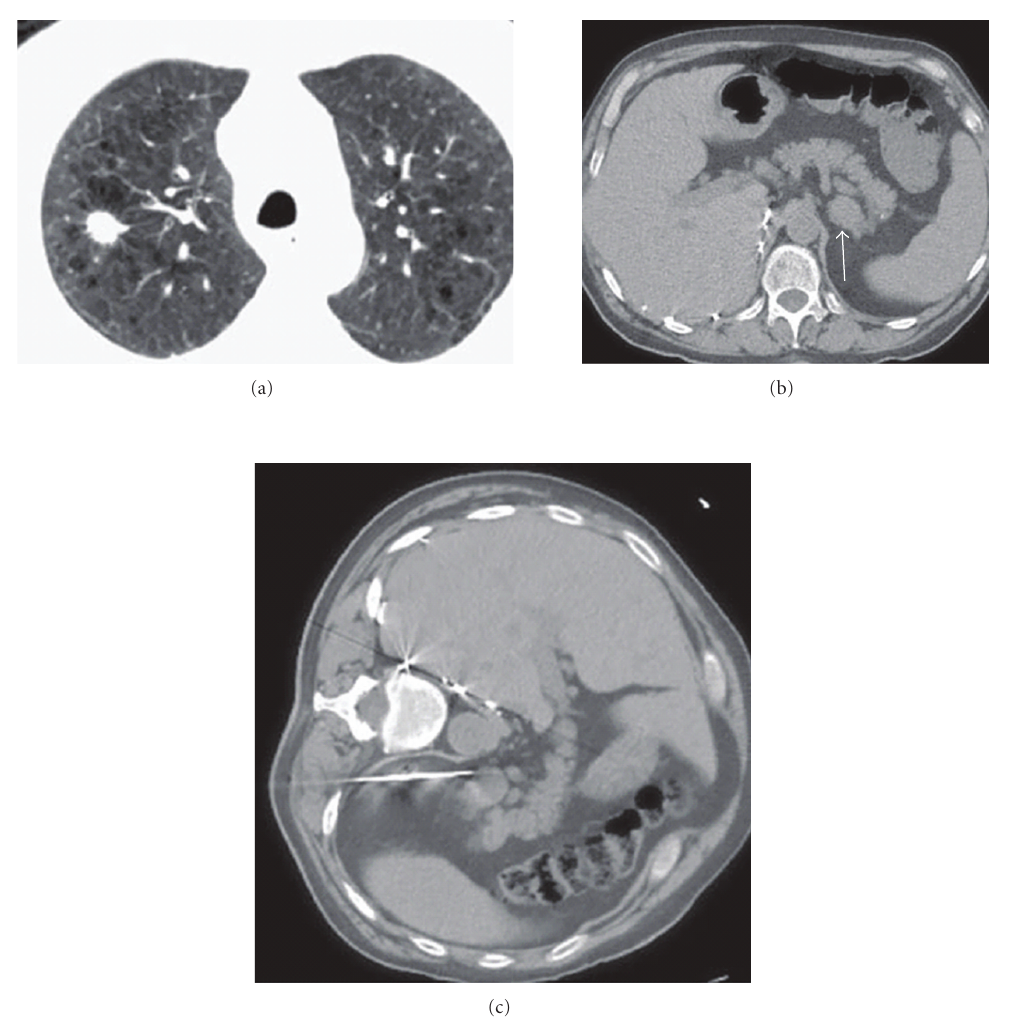
Figure 2: 72-year-old-man with right lung mass and adrenal mass: biopsy of adrenal mass facilitates histological diagnosis and definitive staging in one procedure. (a) CT scan shows right upper lobe spiculated nodule. There is severe background emphysema, which increases the risk associated with percutaneous lung biopsy. (b) CT scan of the upper abdomen shows a left adrenal mass (arrow), suspicious for metastatic disease. (c) Percutaneous biopsy of left adrenal gland in left lateral decubitus position achieves histological diagnosis and confirms advanced staging. The risk of pneumothorax is